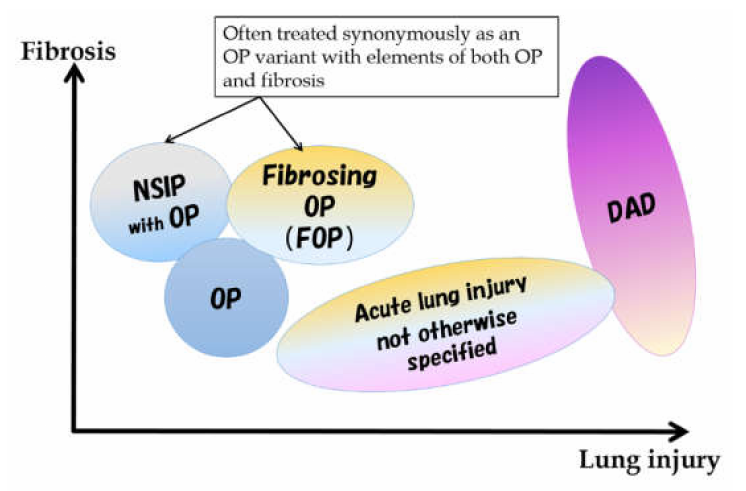
Figure 3. Spectrum of morphological patterns in subacute to acute pathologies. NSIP: nonspecific interstitial pneumonia, OP: organizing pneumonia, DAD: diffuse alveolar damage.